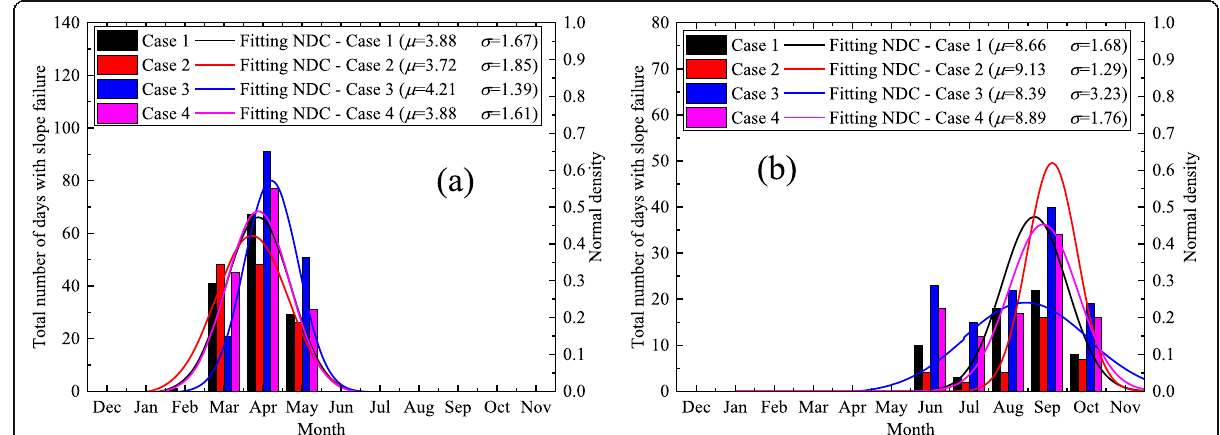
Fig. 9 Total number of days with slope failure and the fitting normal density curve (NDC) of 64 numerical models. a during the Winter-Spring period; and ( b ) during the Summer-Autumn